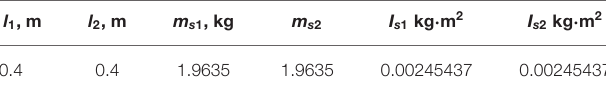
TABLE 1 | Parameters of the simulational manipulator with air